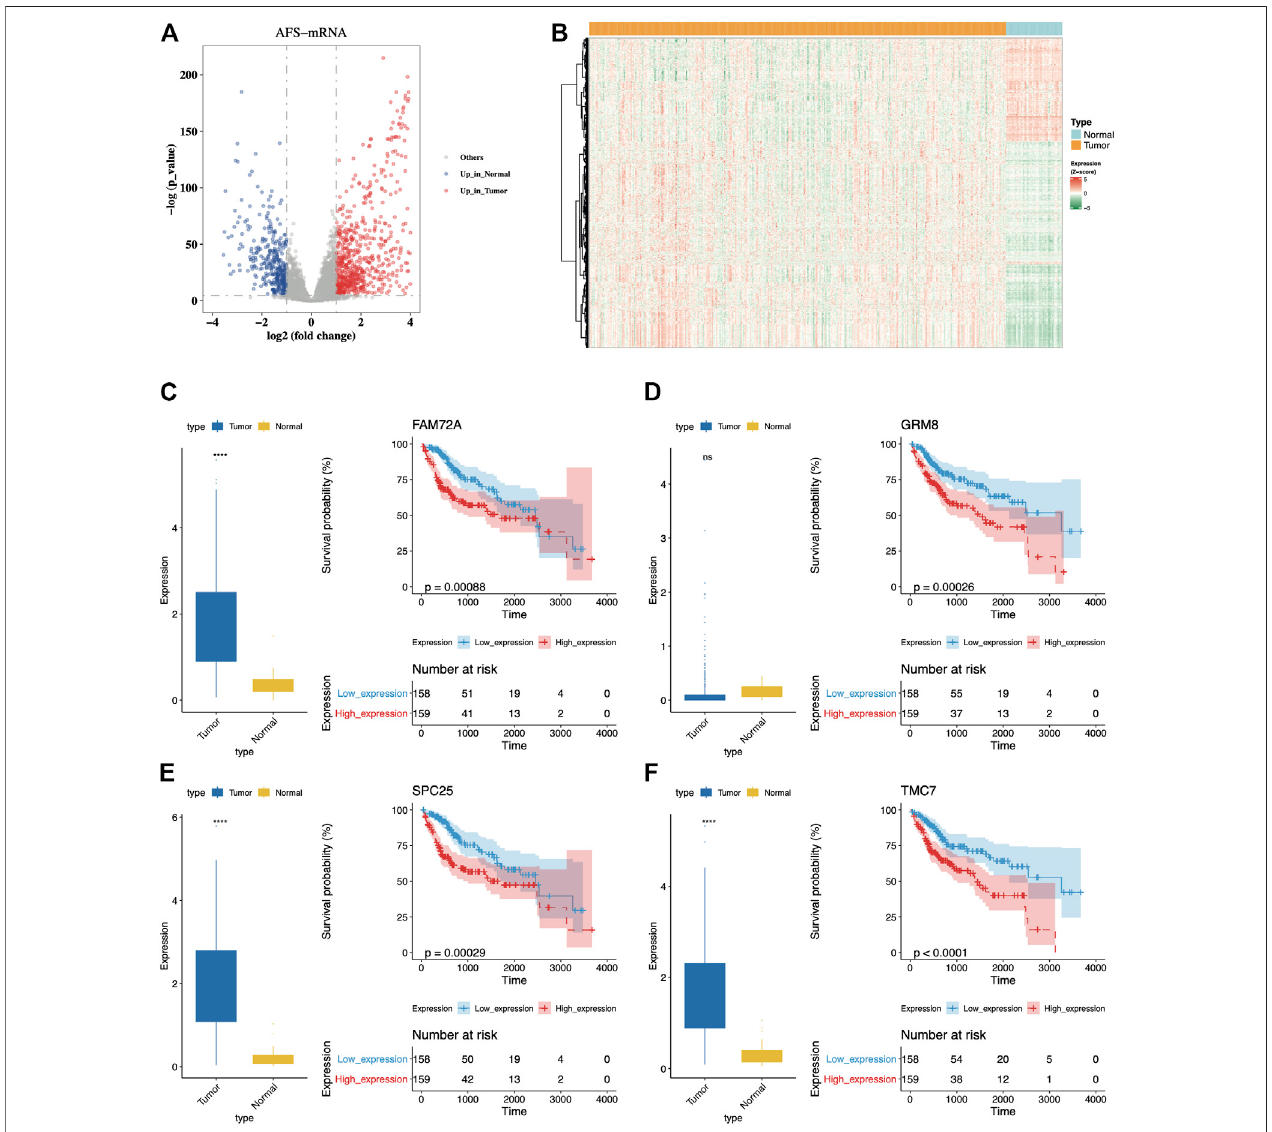
FIGURE 1 | Dysregulated AFs could distinguish OS of patients. ( A) The volcano plot of differential expressed AFs genes between tumor and normal samples from the TCGA-LIHC cohort. The red dots indicated upregulated genes while blue dots indicated downregulated genes in tumors. (B) The distribution of expression levels of the differential expressed AFs genes. (C-F) Comparison of expression levels between tumor and normal samples and K-M curves for the four genes with top signi fi cance. The prognostic group was separated using the median expression of each gene as the